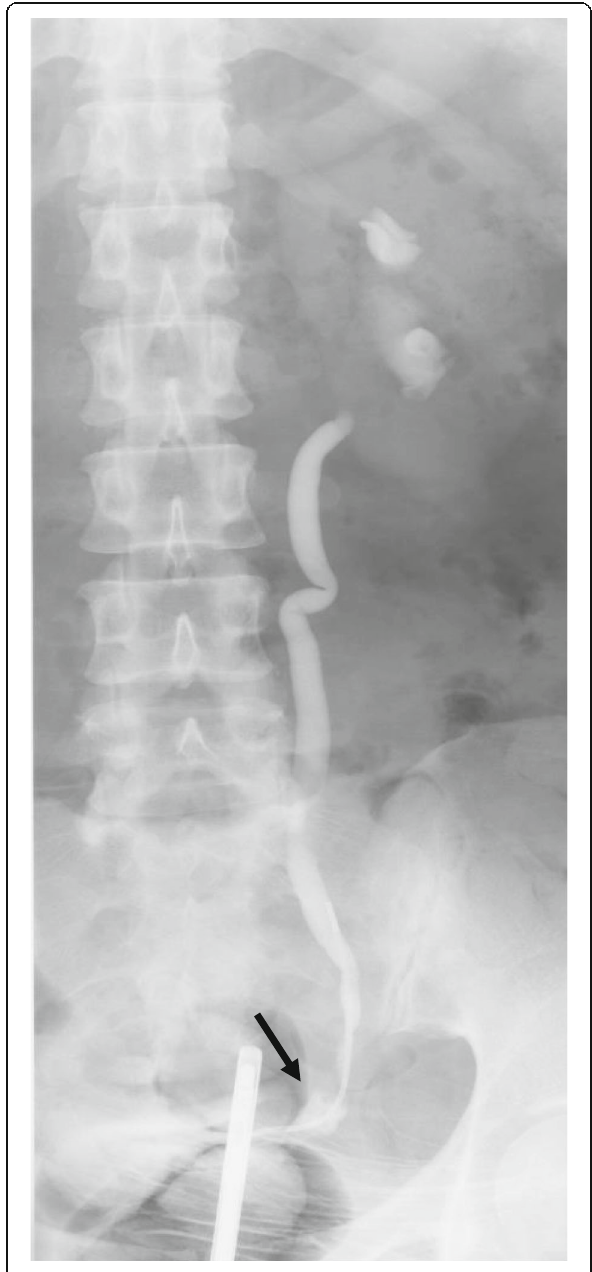
Fig. 1 Retrograde pyelography revealed a left uretero-vaginal fistula